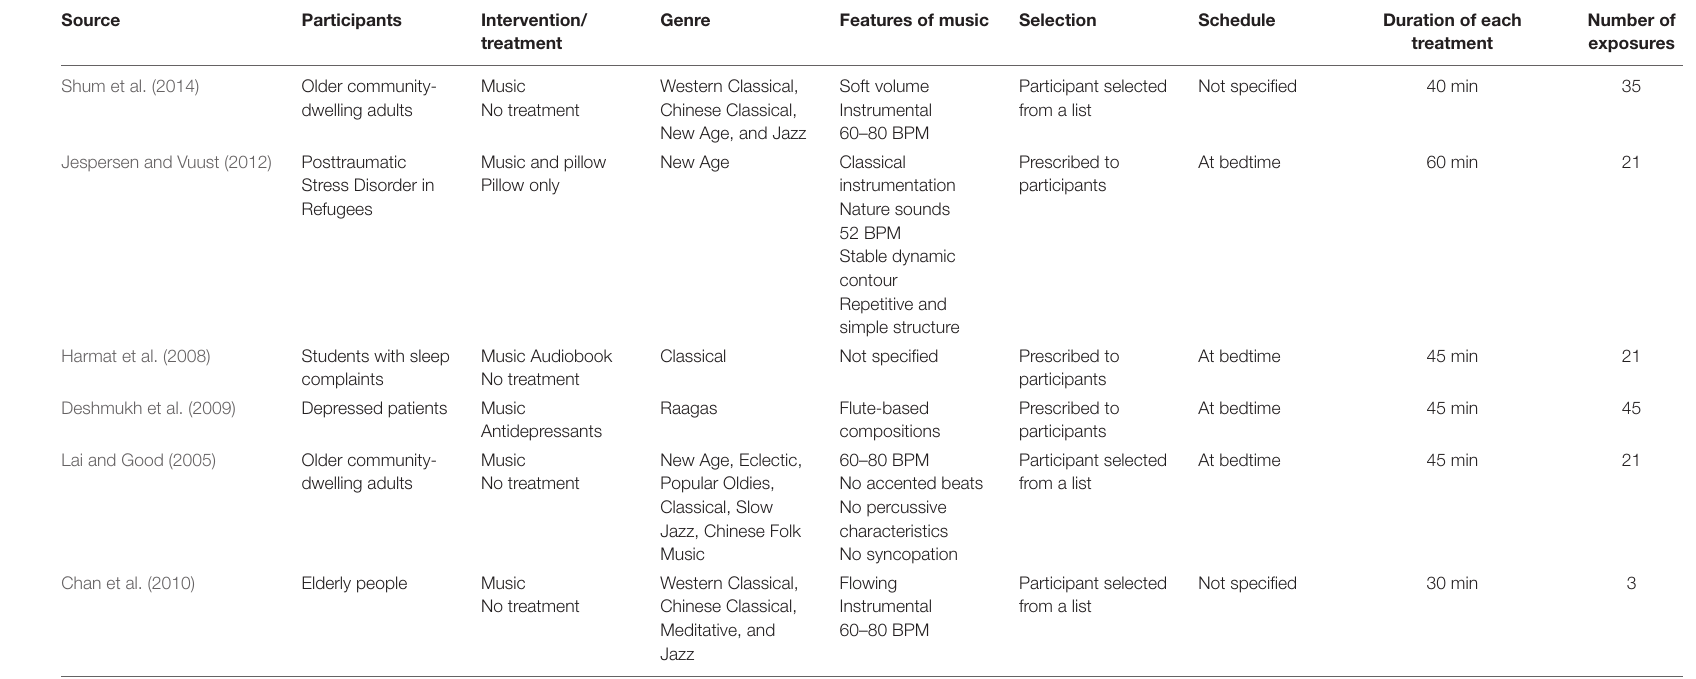
TABLE 3 | Music sleep study characteristics and